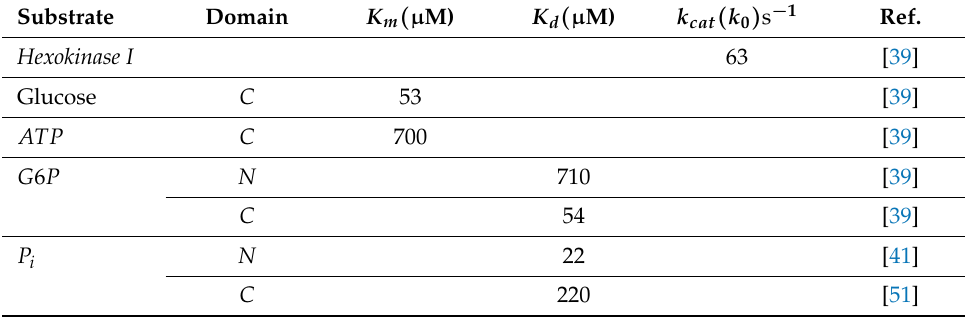
Table 1. Some model parameter values and their literature sources.